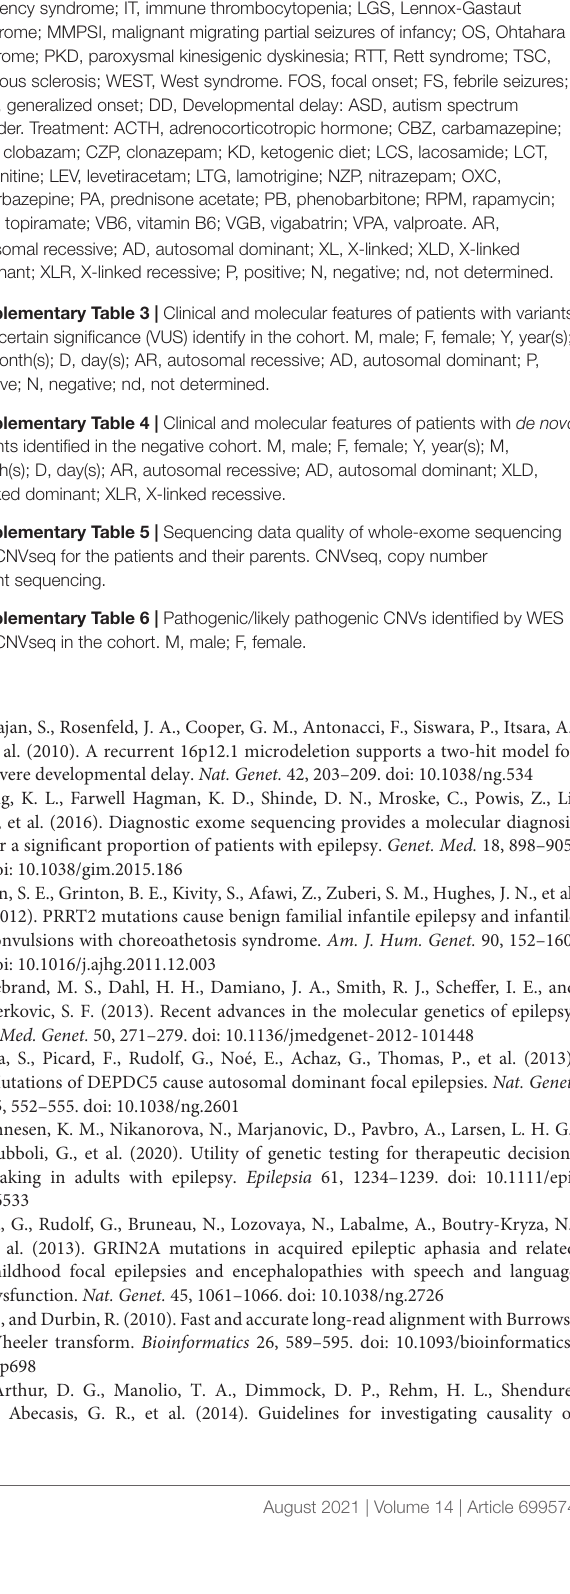
Supplementary Table 2 | Clinical and molecular features of positive patients with positive genetic diagnosis. M, male; F, female; Y, year(s); M, month(s); D, day(s). Diagnosis: BFIS, benign familial infantile seizures; CCHD, critical congenital heart disease; CPVT, catecholaminergic polymorphic ventricular tachycardia; DOOSE, Doose Syndrome; DS or DS-like, Dravet syndrome or Dravet syndrome-like; EAS, epilepsy-aphasia spectrum; EE, epileptic encephalopathy; FE, focal epilepsy; FFEVF, familial focal epilepsy with variable foci; GE, generalized epilepsy; GEFS + , genetic epilepsy with febrile seizures plus; GULT1-DS, glucose transporter type 1